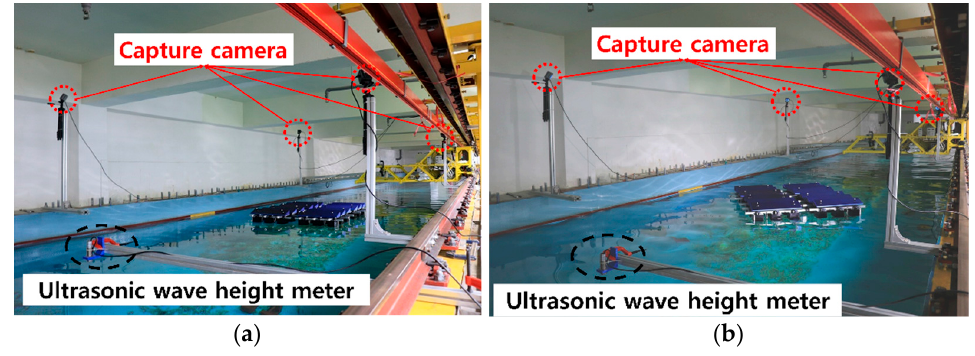
Figure 6. Experimental setup: ( a ) head sea conditions; ( b ) oblique sea condition.